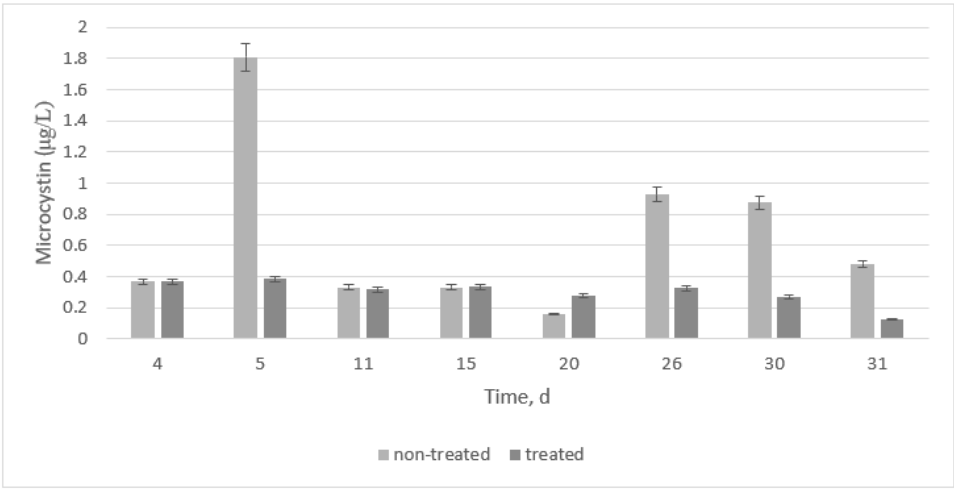
Figure 2. Microcystin production for non-treated and treated samples. Error bars represent